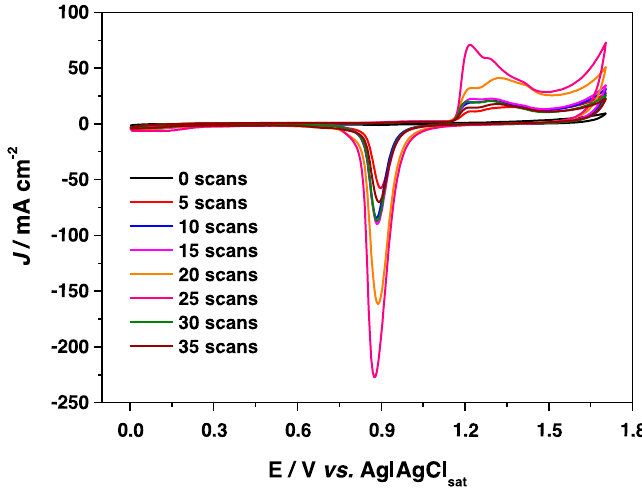
Table 1. Characterization of AuNPs on GC modified electrodes for different numbers of cyclic scans (N) during the electrodeposition step. Experimental conditions: 10 mM Fe(CN) 63 − /4 − in 50 mM TRIS buffer pH 7.4 with 0.1 M KCl for electroactive area ( A EA ), real surface area ( A real ), electron transfer rate constant ( k 0 ) and roughness factor ( ρ ) determination; 0.5 M H 2 SO 4 at a scan rate of 100 mV s − 1 , for A real